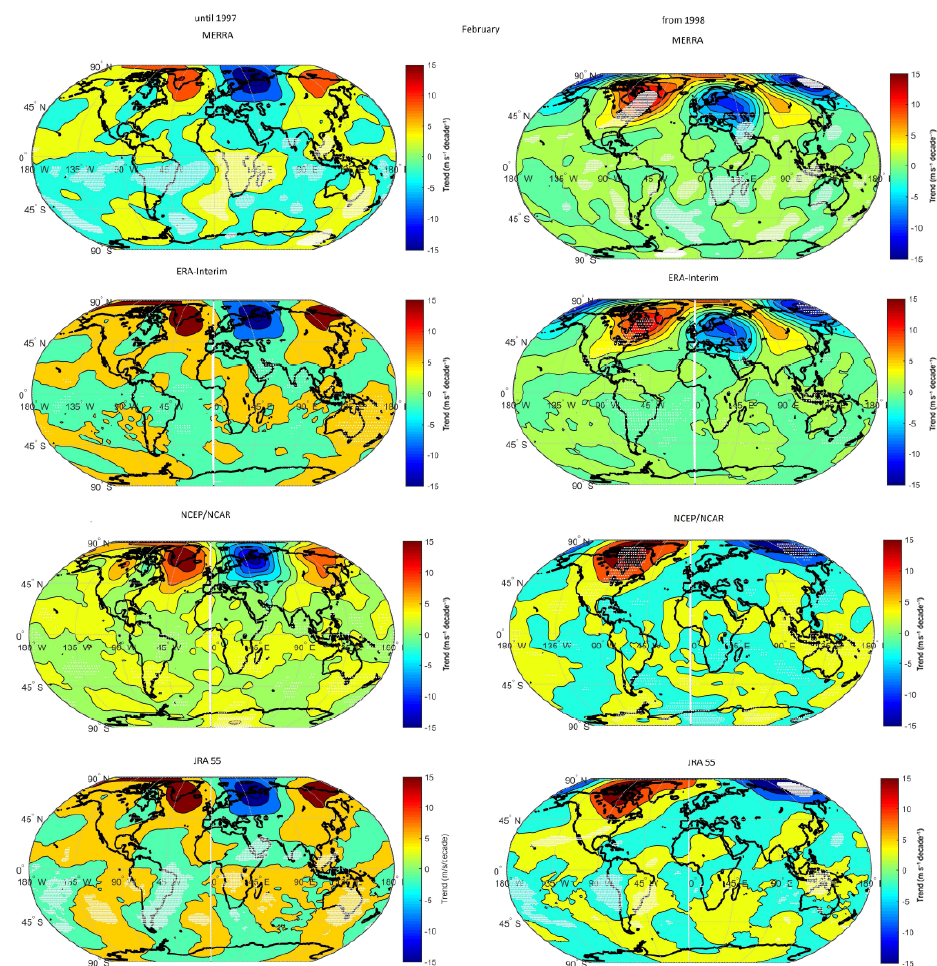
Figure 10. The difference between meridional wind trends for 2 consequent months (top to bottom: differences between November and December, differences between December and January, differences between January and February, differences between November and February) from the MERRA reanalysis at 10hPa. Left panels show 1979–1997 and right panels show 1998–2015.